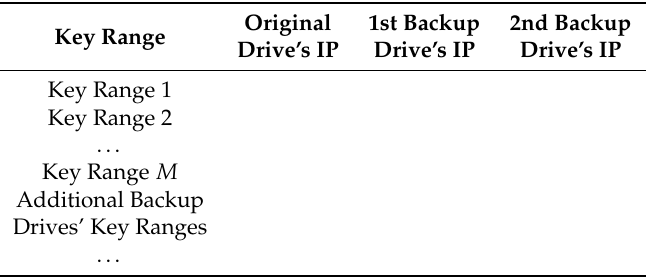
Table 2. Mapping table maintained in each metadata